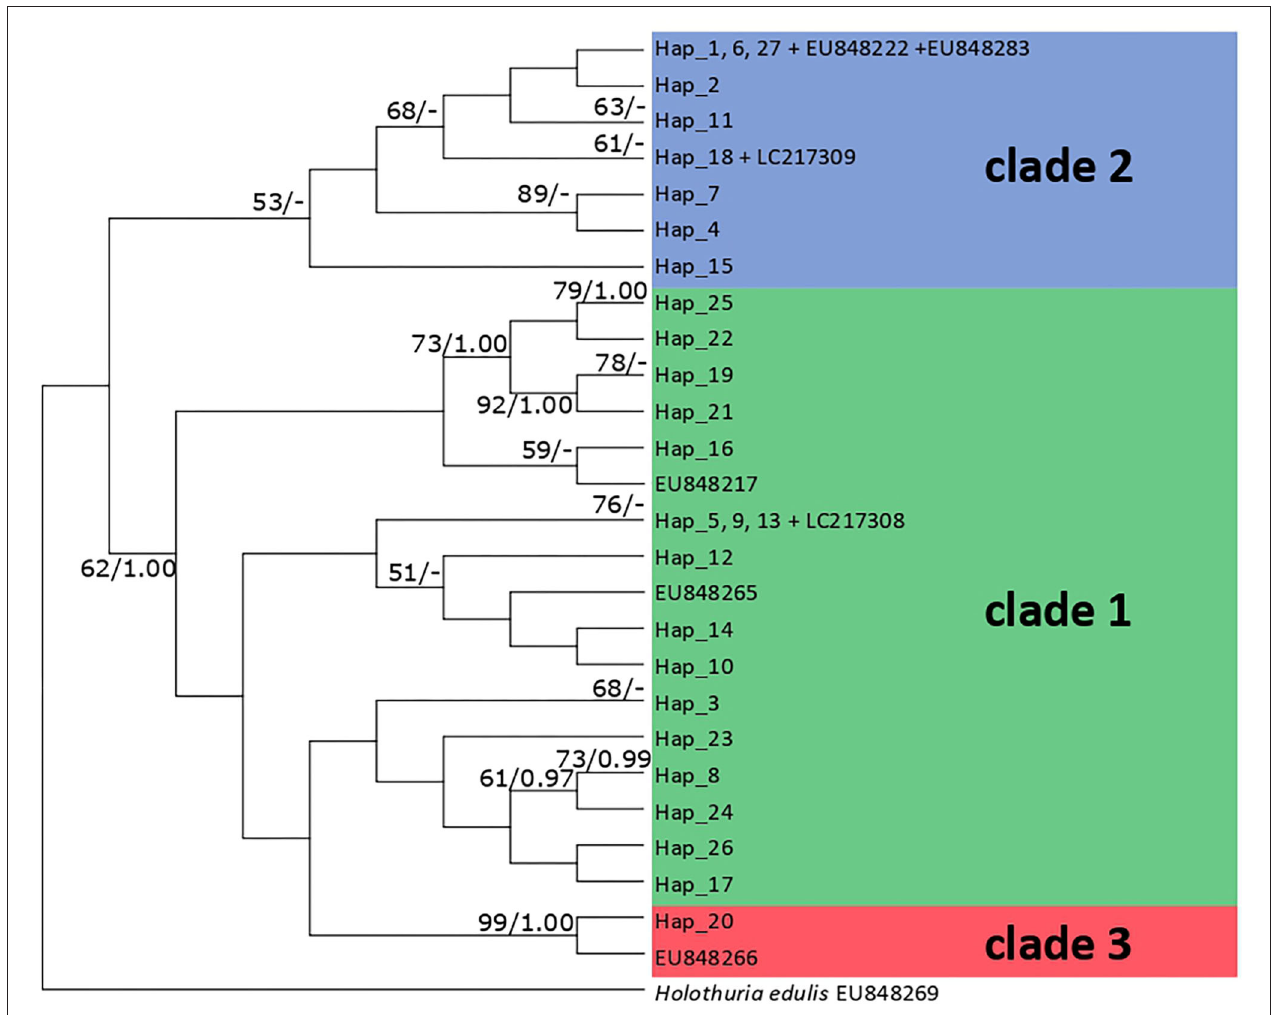
FIGURE 4 | Maximum Likelihood phylogenetic tree based on COI sequences of H. atra . Only bootstrap values > 50 are shown on the left, only > 0.95 Bayesian support values are shown on the right. Each color indicates clades as reported in a previously published phylogeny (Uthicke et al., 2010). Note several haplotypes includes multiple samples. Please see also Supplementary Table 2 to match samples to each